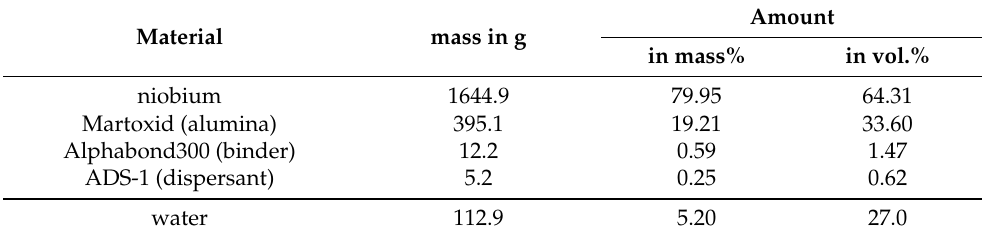
Table 2. Castable recipe for the fine-grained